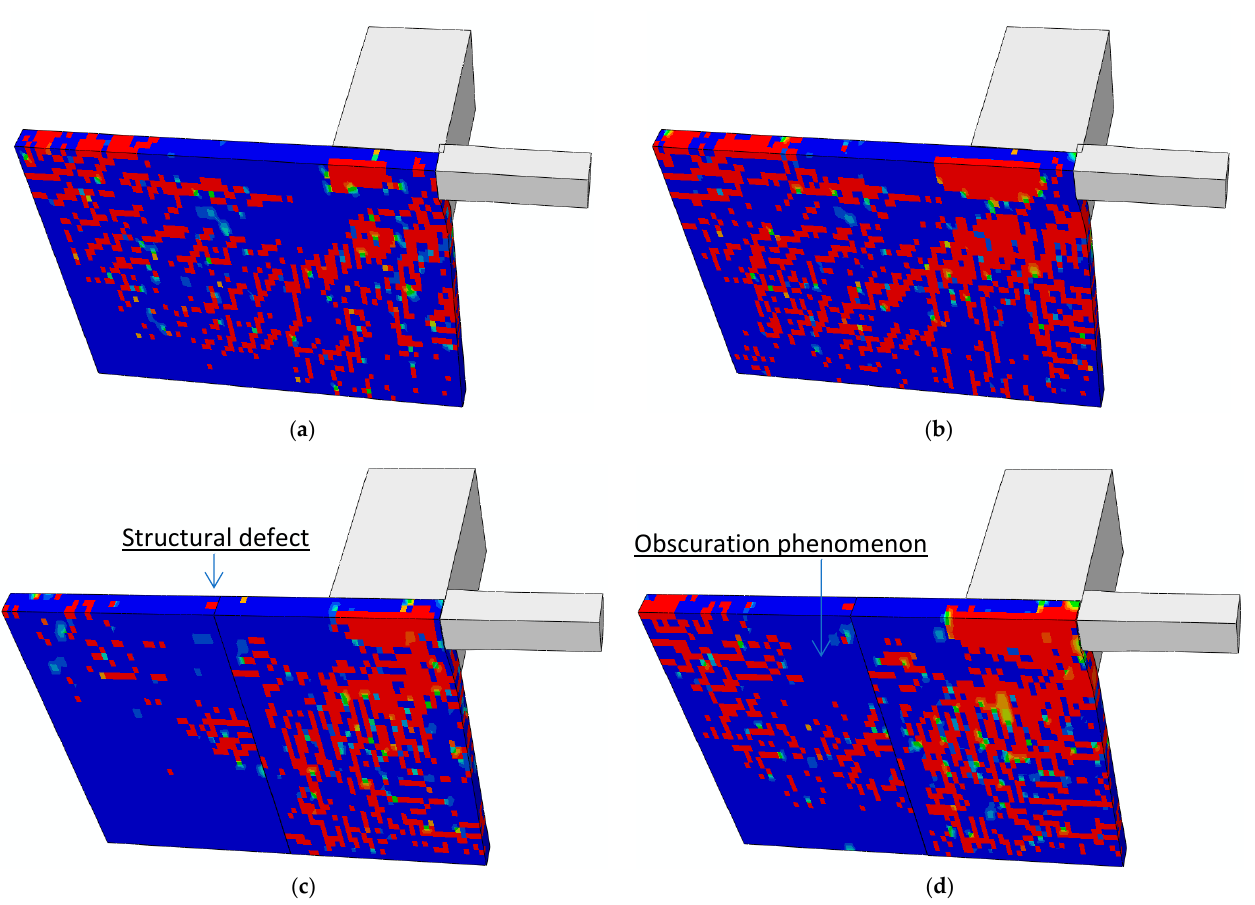
Figure 13. Field of damage within the target (in red: D 1 = 1, in blue: D 1 = 0). ( a , c ) T = 40 µs, ( b , d ) T = 48 µs. ( a , b ) Case without structural defect. ( c , d ) Case with a structural defect located halfway between the front edge and the rear edge.